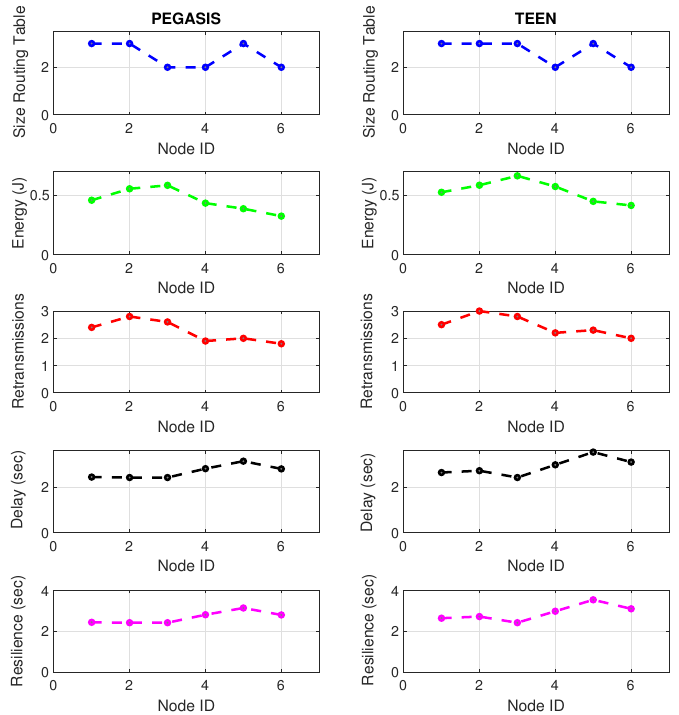
Figure 21. LoRa network deployment under normal